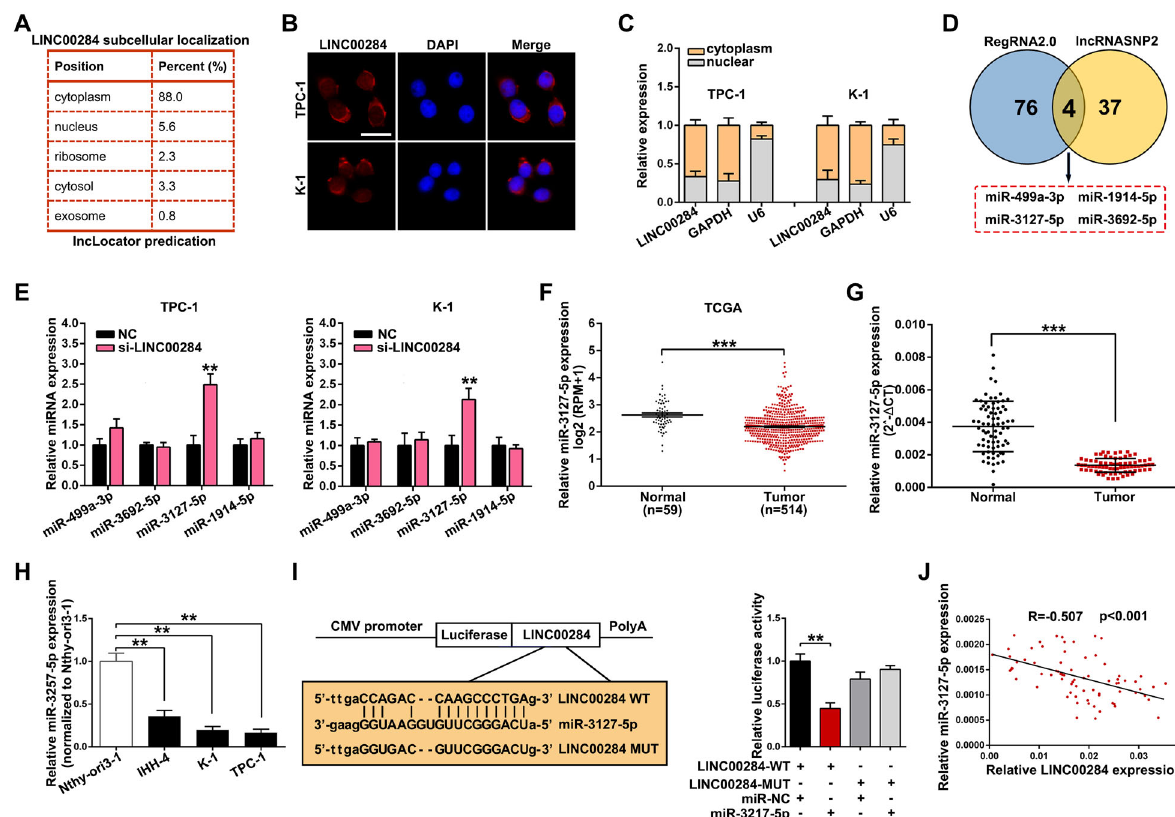
Fig. 4 LINC00284 serves as a ceRNA sponging miR-3127-5p. A The online tool lncLocator was utilized to forecast the subcellular localization of LINC00284. B RNA FISH assay was performed to analyze the location of LINC00284 in the nuclear (blue) and cytoplasm (red) fractions in TPC-1 and K-1 cells (scale bar: 50 μ m). C The subcellular fractionation assay veri fi ed the location of LINC00284 in TPC-1 and K-1 cells. D Bioinformatics analyses screened the miRNAs binding with LINC00284 by RegRNA 2.0 and lncRNASNP2. E The expression levels of